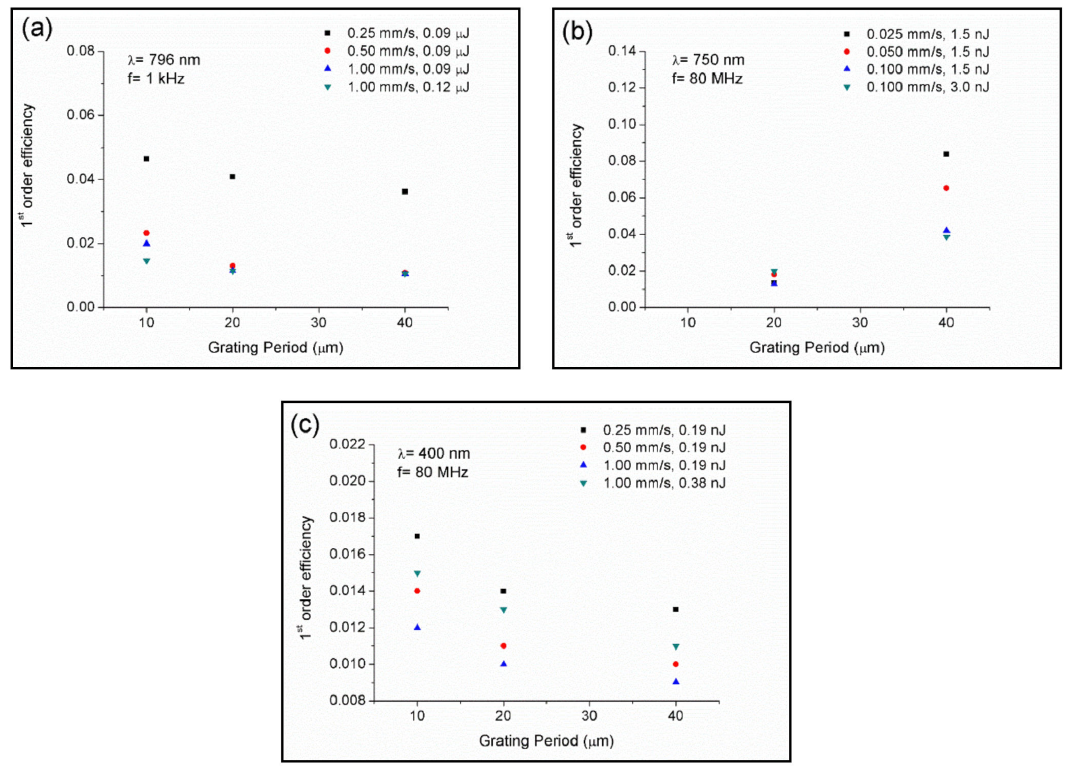
Figure 7. First-order e ffi ciency of the samples processed with the laser amplifier at 796 nm ( a ), laser oscillator at 750 nm ( b ), and laser oscillator at 400 nm ( c